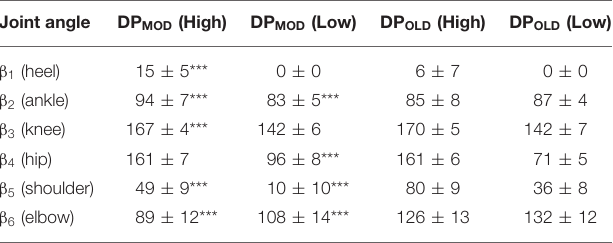
Frontiers in Sports and Active Living |